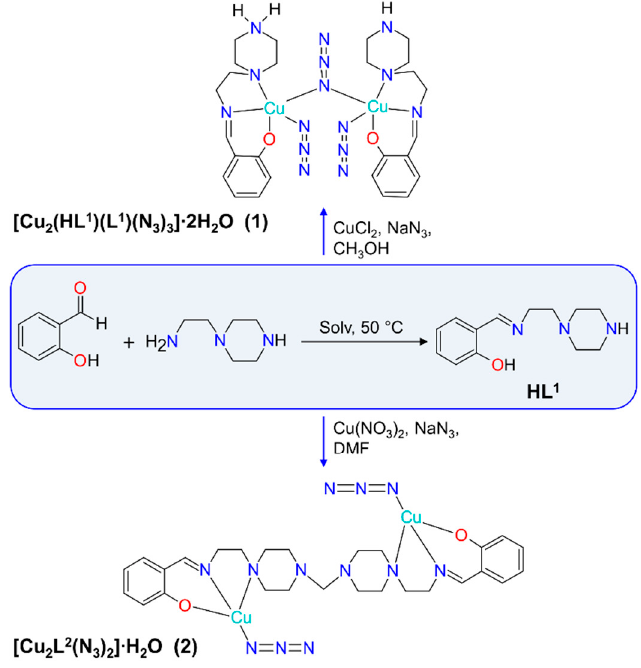
Figure 1. Schematic representation of the formation of 1 and 2 .